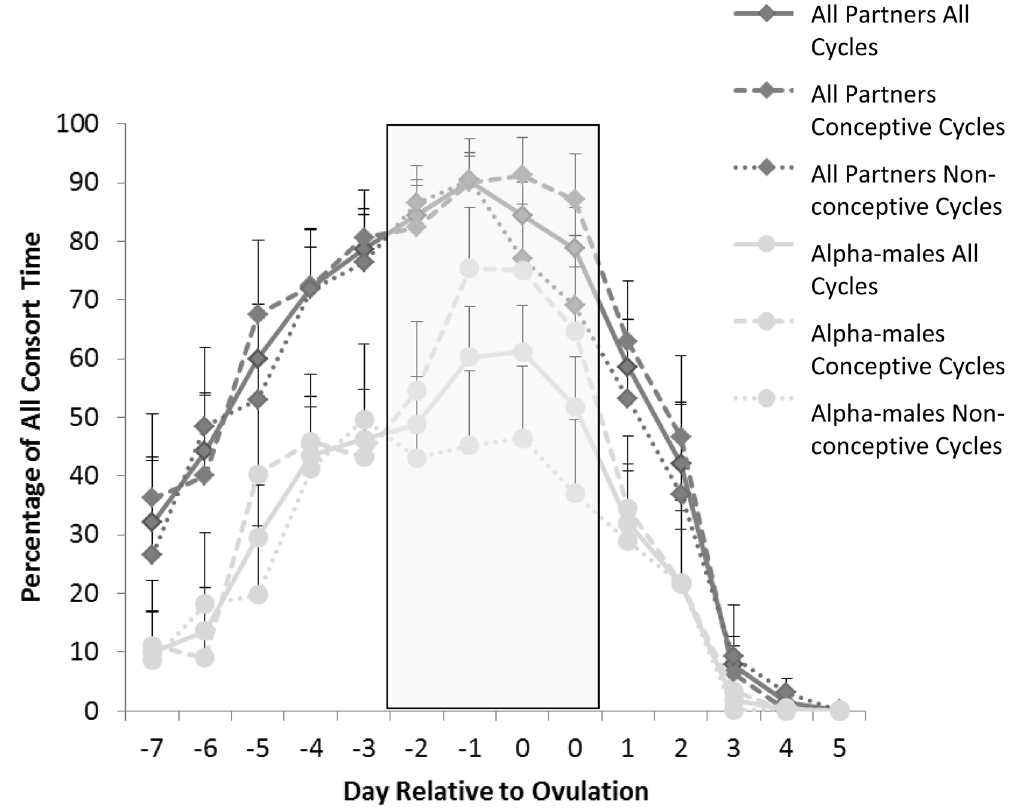
Figure 3. Percentage of time females spent in consort with all consort partners and with alpha-males in all cycles, as well as in conceptive and non-conceptive cycles separately, for each day with respect to the 2 day ovulation window (mean and standard deviation). The grey box indicates a presumed 4 day fertile